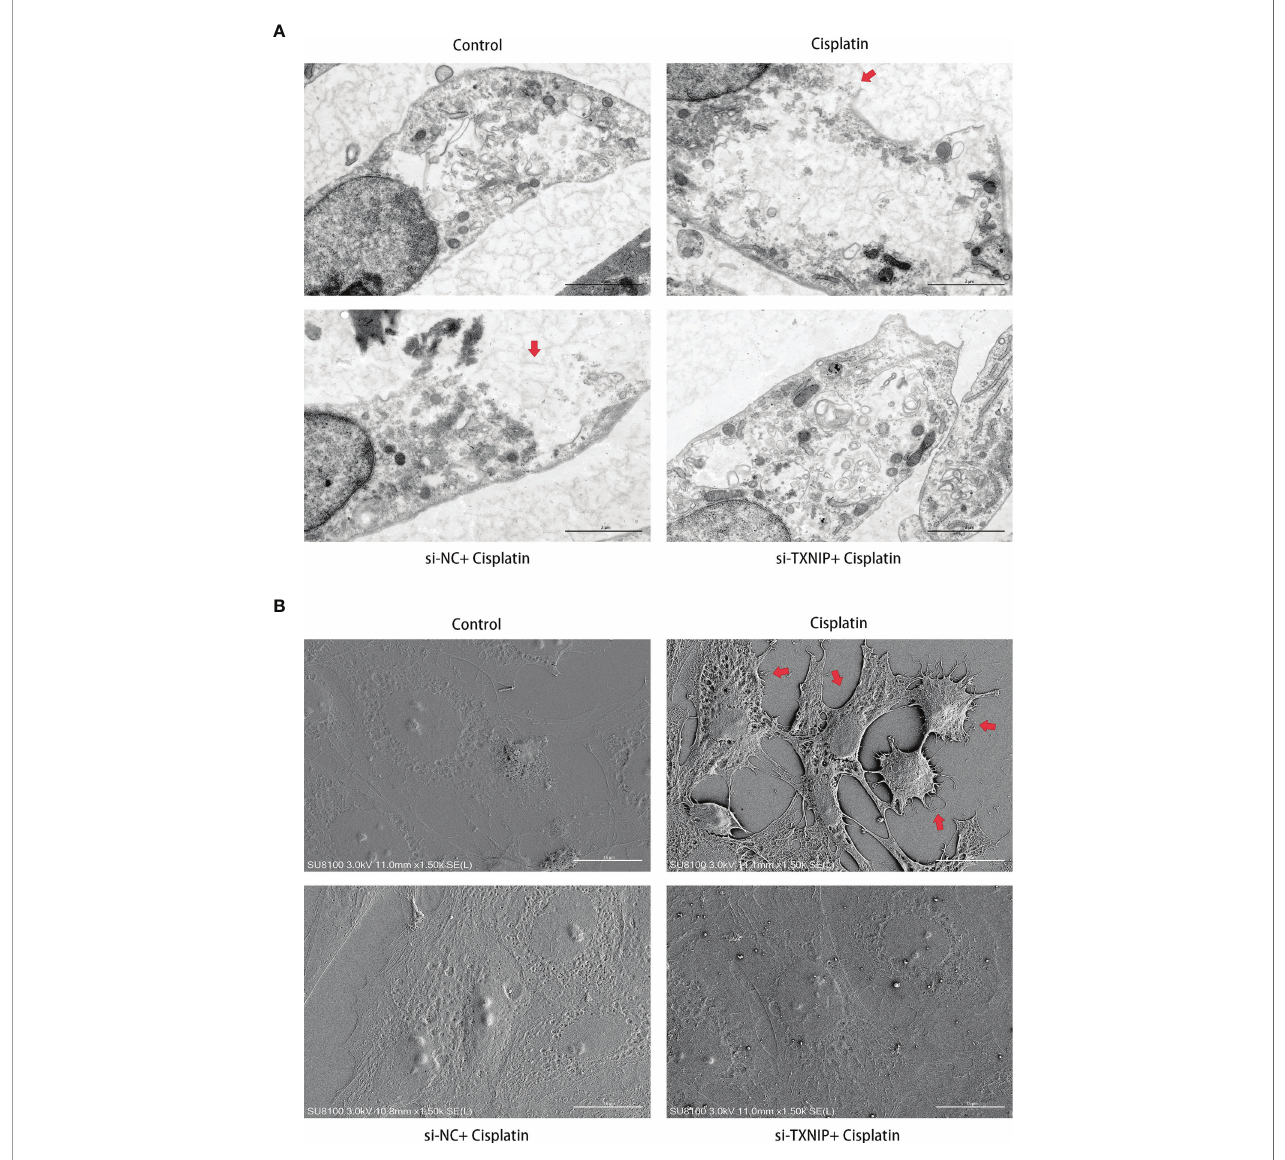
FIGURE 9 | Downregulation of TXNIP reversed the cisplatin-induced ultramicroscopic changes in MCs, similar to that after downregulating NLRP3. (A) The morphologic changes of MCs after different treatments were evaluated under TEM. The red arrows indicate the ruptured cell membrane and local lighter-stained cytoplasm. Scale bars: 2 µm. (B) The morphological changes of MCs were observed by SEM. The red arrows indicate the withered tree-like cell membrane at the edge of the cell. Scale bars: 15 µm. Representative results of at least three repeated experiments are